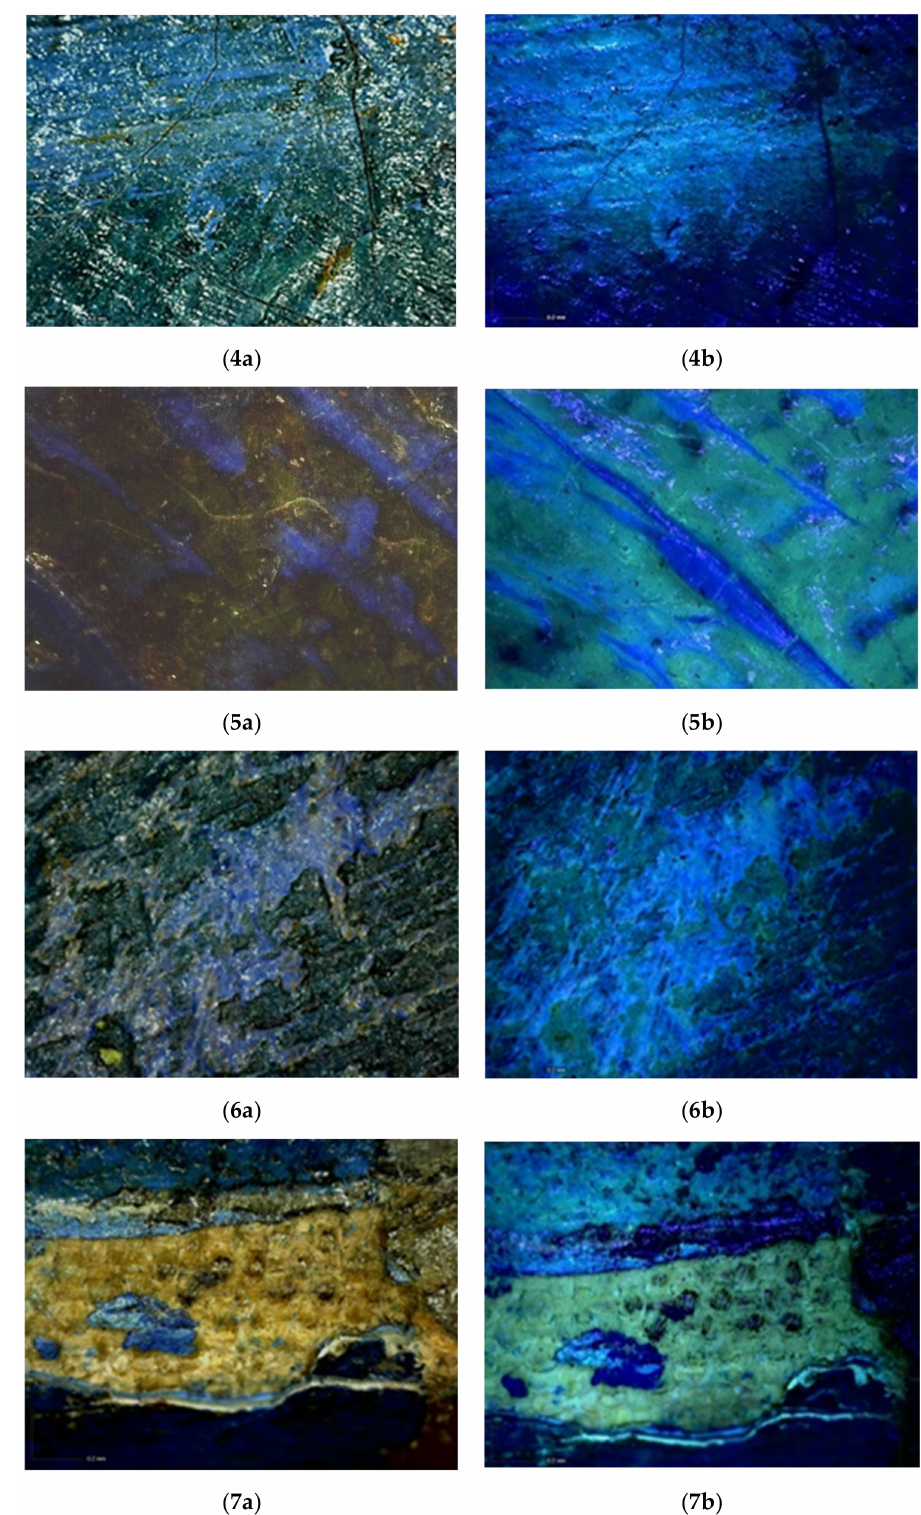
Figure 4. DinoLite images (50 × enlargements) with numbers in the caption corresponding to the map in Figure 1. Details of the lifted areas in VIS ( 1a ) and UV light ( 1b ). Details of the varnish and the paint layers in VIS ( 2a – 5a ) and UV light ( 2b – 5b ). Details of the restored areas (chromatic reintegration) in VIS ( 6a ) and UV light ( 6b ). Details of the color gap, the canvas, and part of the overlying layers in VIS ( 7a ) and UV light ( 7b